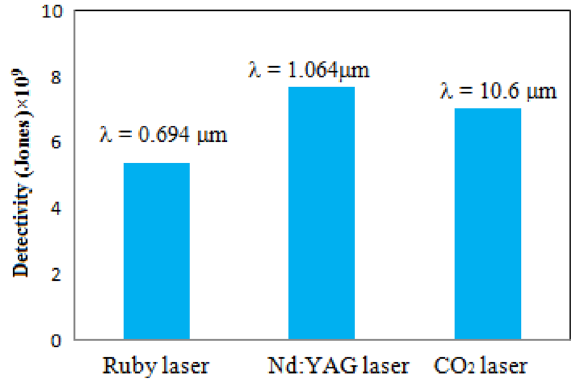
Figure 14. Histogram of detectivity of the detector prepared at θ = 70° as a function of laser wavelength at zero bias.